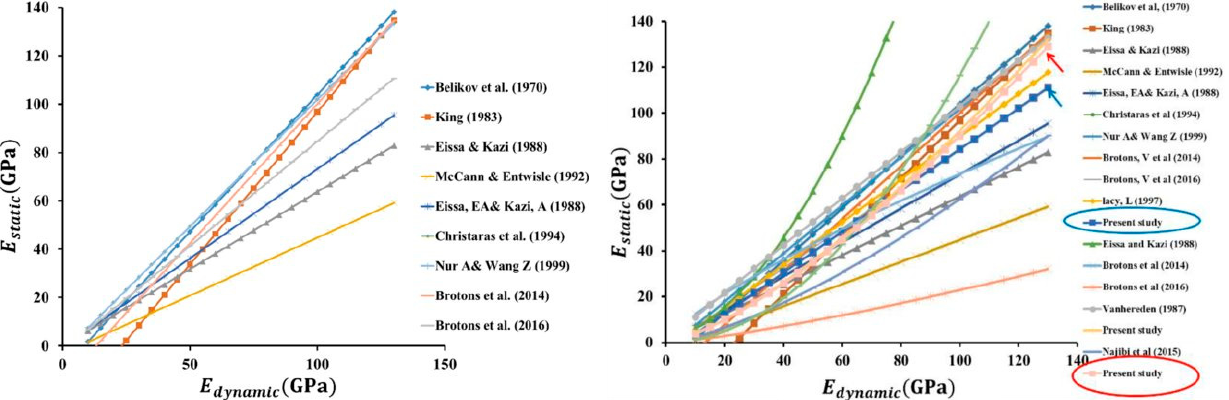
Figure 13. Linear and nonlinear (power and logarithmic) relationships between the measured static and dynamic modulus of elasticity [54].